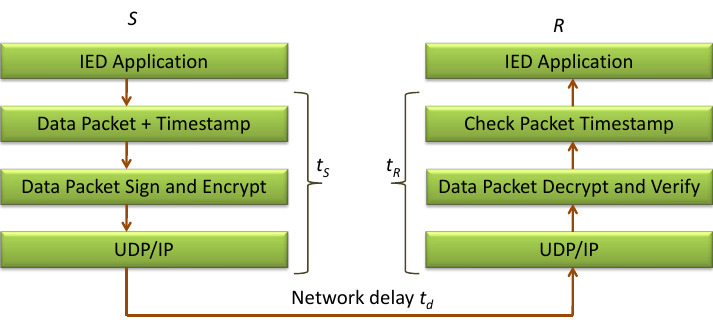
Figure 4. End to end communication model within